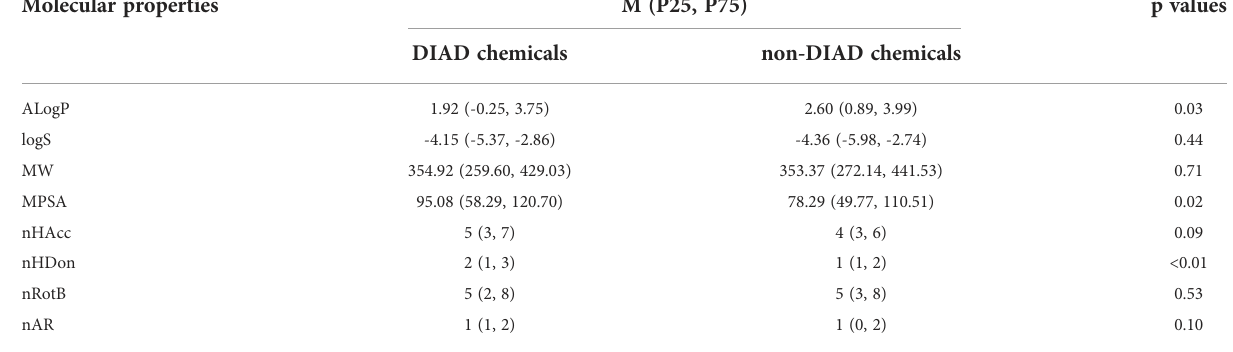
TABLE 4 Distributions of the molecular properties for DIAD and non-DIAD chemicals. Molecular properties